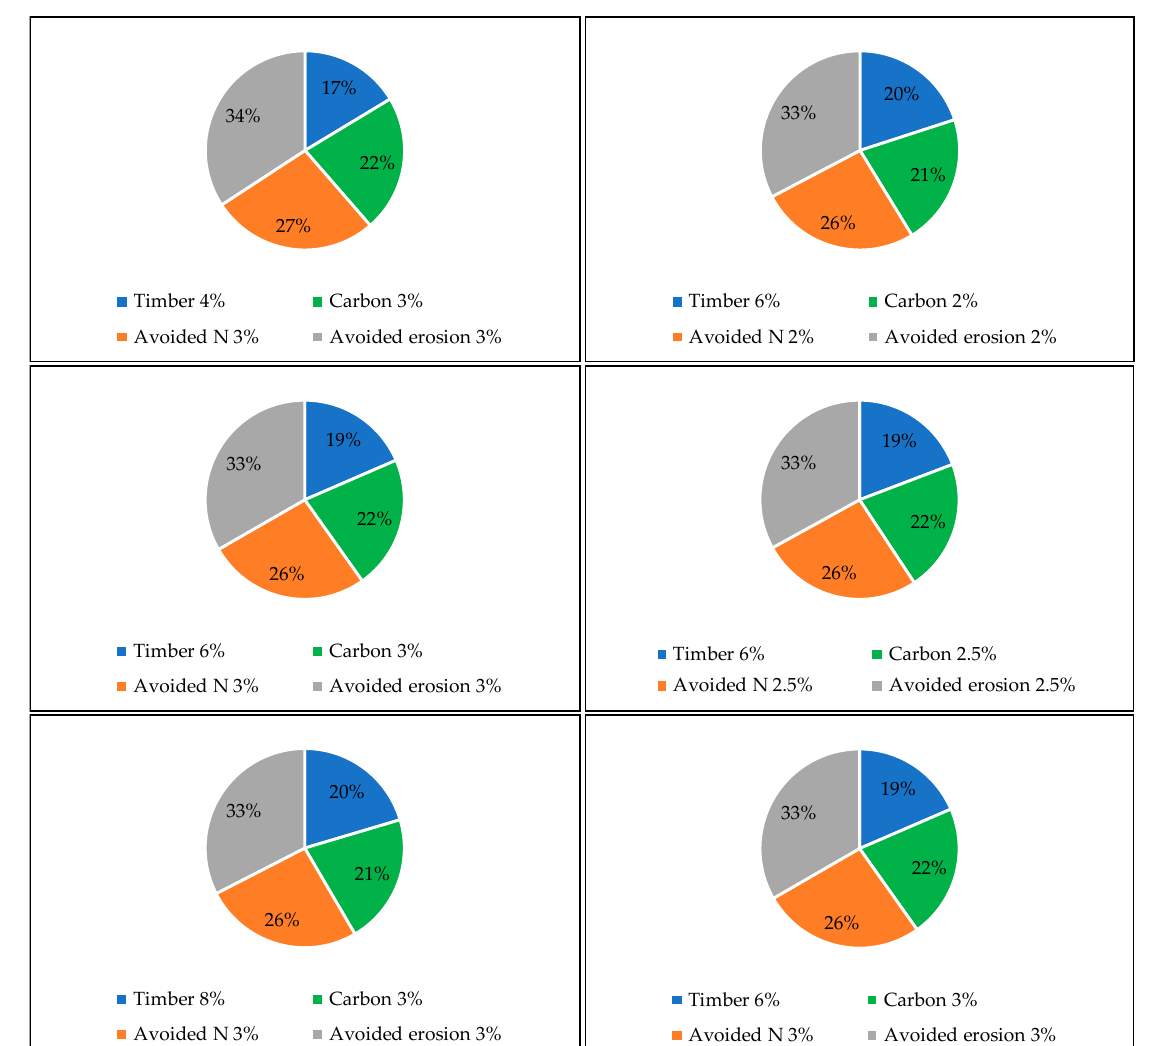
Figure 5. Pie charts showing the impacts of different discount rate combinations on the distribution of the four ES values provided by NZ planted forests.